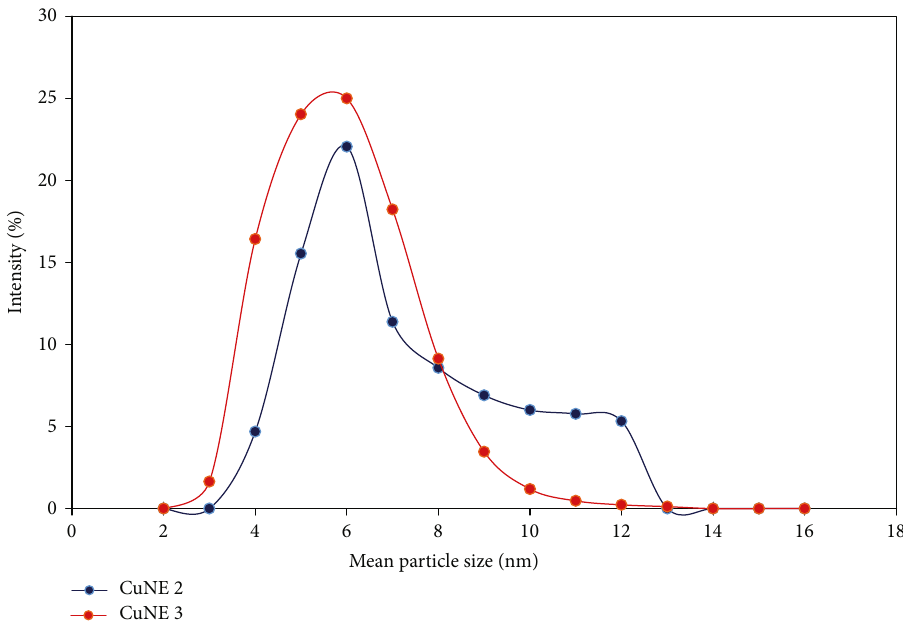
Figure 2: Particle size for stable sample with di ff erent concentrations of curcumin.